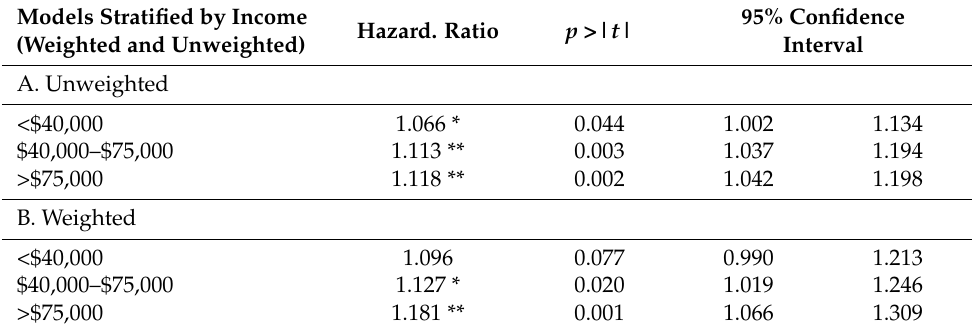
Table 8. Estimated hazard of dying for neighborhood disadvantage for policyholders stratified by personal